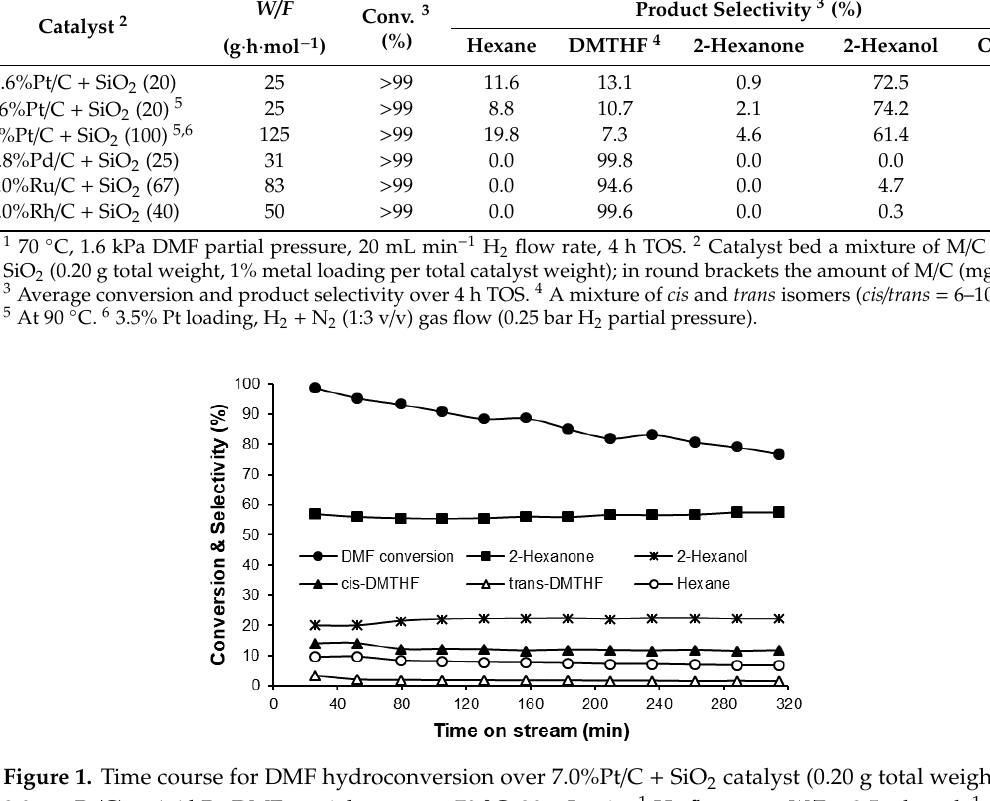
Table 1. Hydroconversion of 2,5-dimethylfuran over noble metal catalysts 1 .